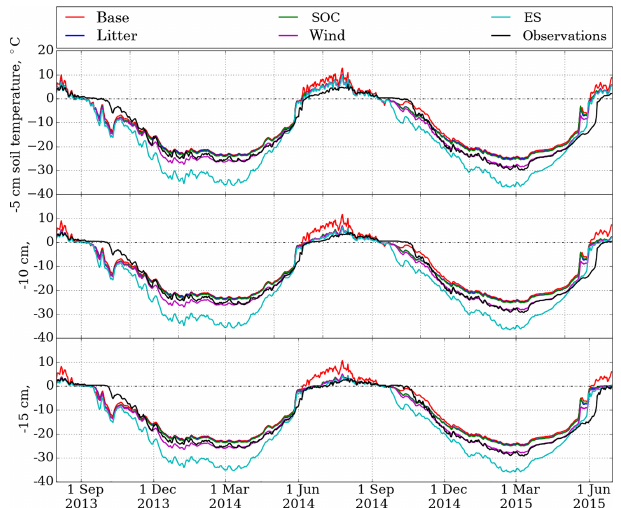
Figure 10. Observed and simulated daily mean soil temperature at 5, 10 and 15cm